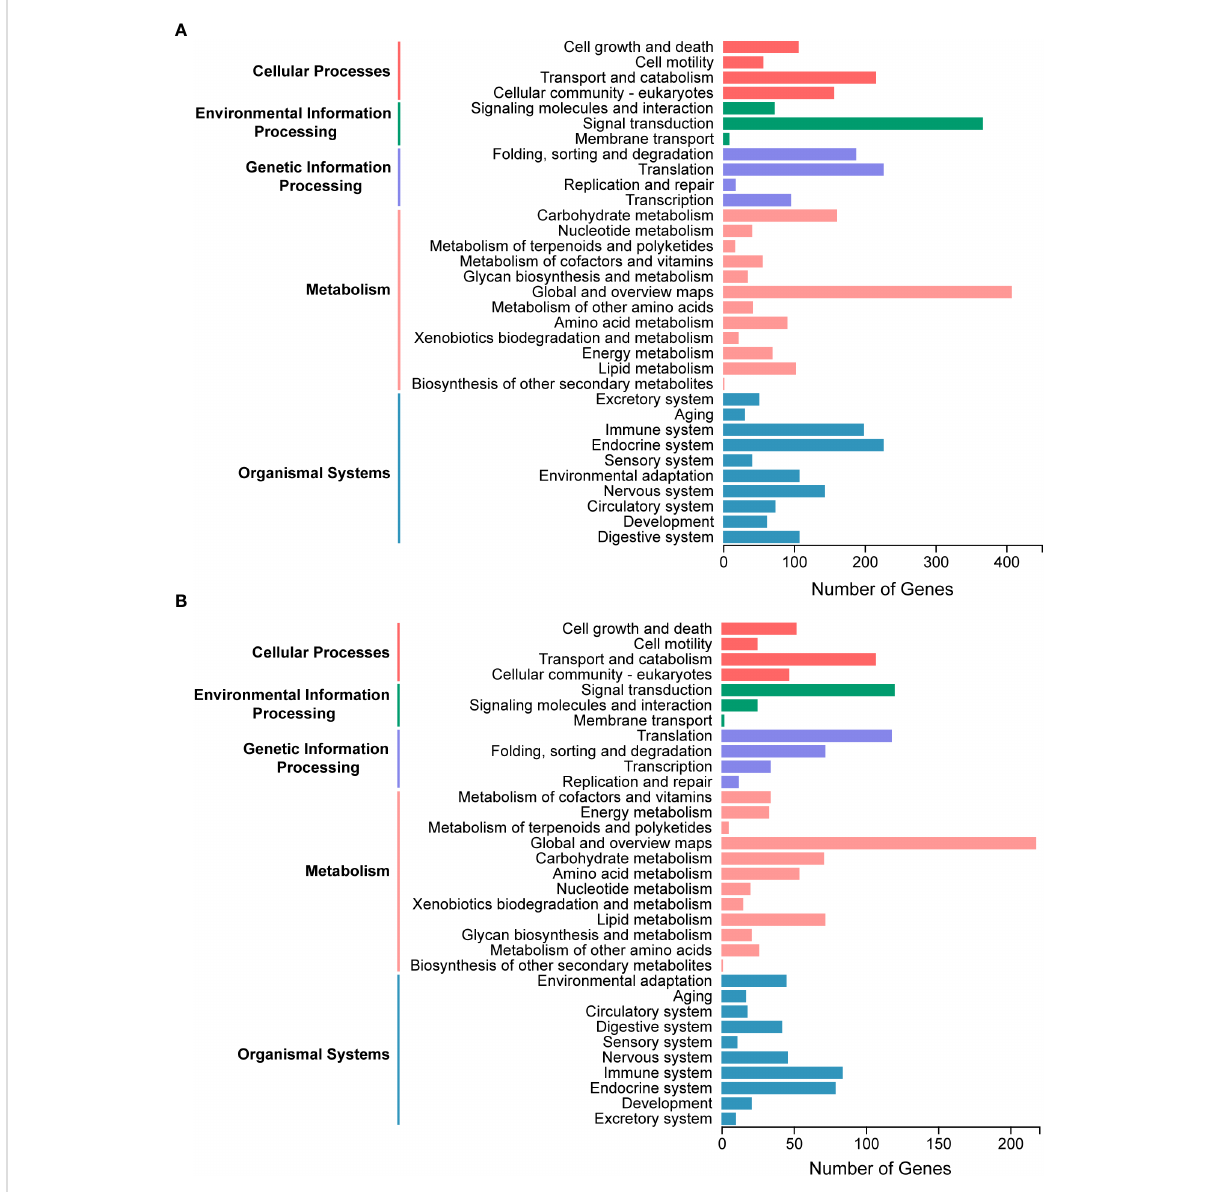
FIGURE 3 Kyoto Encyclopedia of Genes and Genomes (KEGG) pathway analysis of salivary components in Pseudoregma bambucicola . (A) Functional classi fi cation of metabolic pathways for salivary gland proteins. (B) Functional classi fi cation of metabolic pathways for putative saliva proteins secreted into